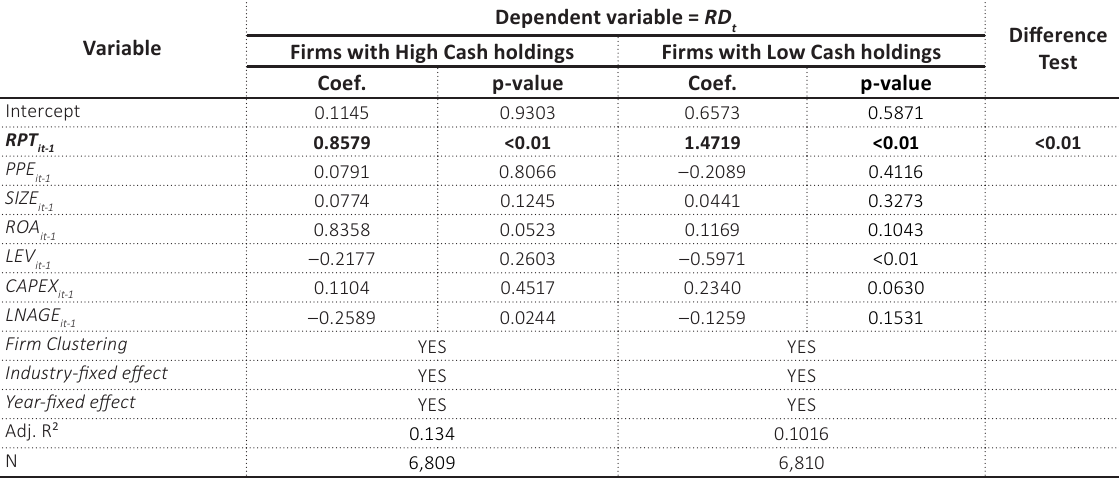
Test Firms with High Cash holdings Firms with Low Cash holdings